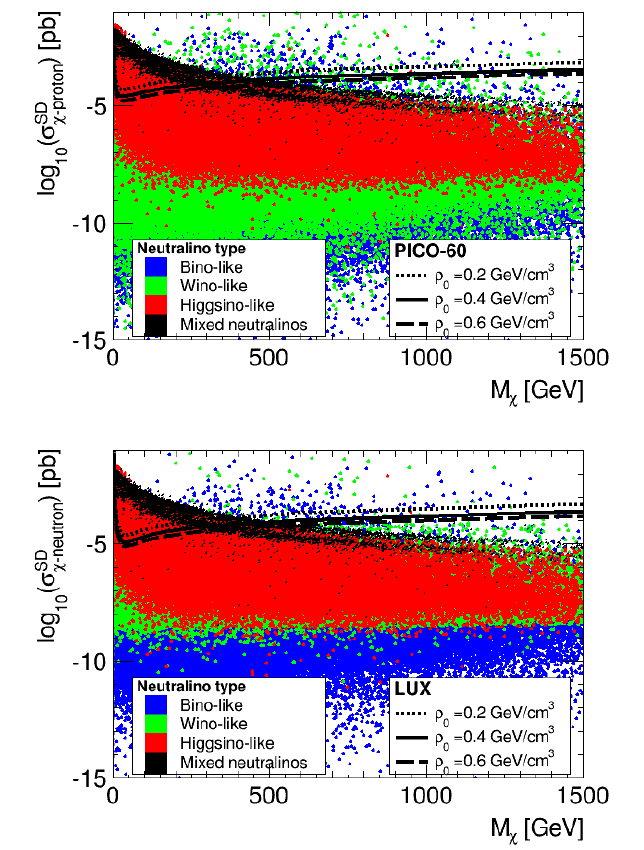
Figure 13 . Spin-dependent neutralino scattering cross section with proton (upper panel) and with neutron (lower panel) as a function of the neutralino mass. The lines show the LUX and PICO-60 90% C.L. upper limits for three di(cid:11)erent values of the local dark matter density (cid:26) 0